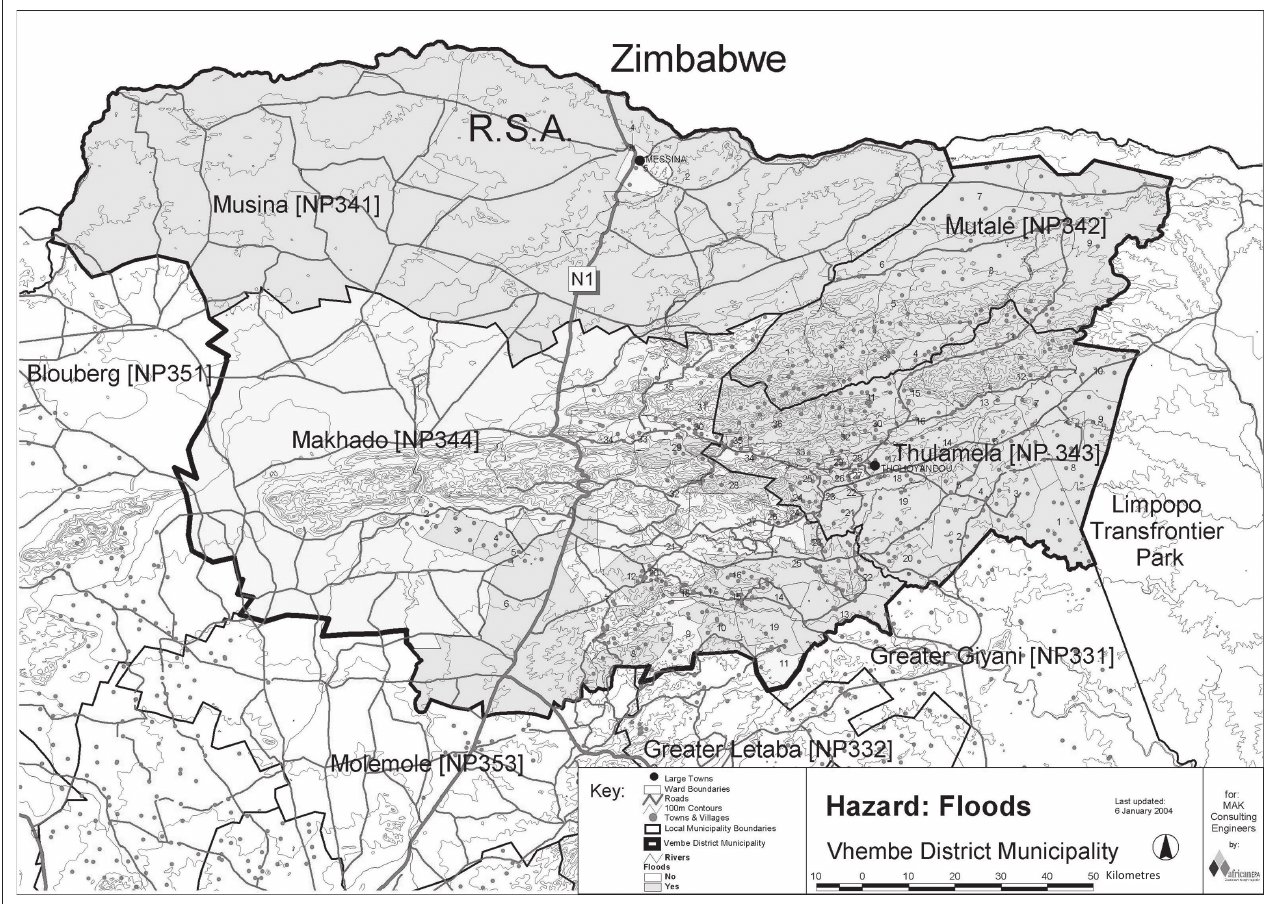
FIGURE 1: Location of Vhembe District Municipality in South Africa and all areas vulnerable to flood hazard. Dark grey areas are more vulnerable to flooding (Musina, Mutale and